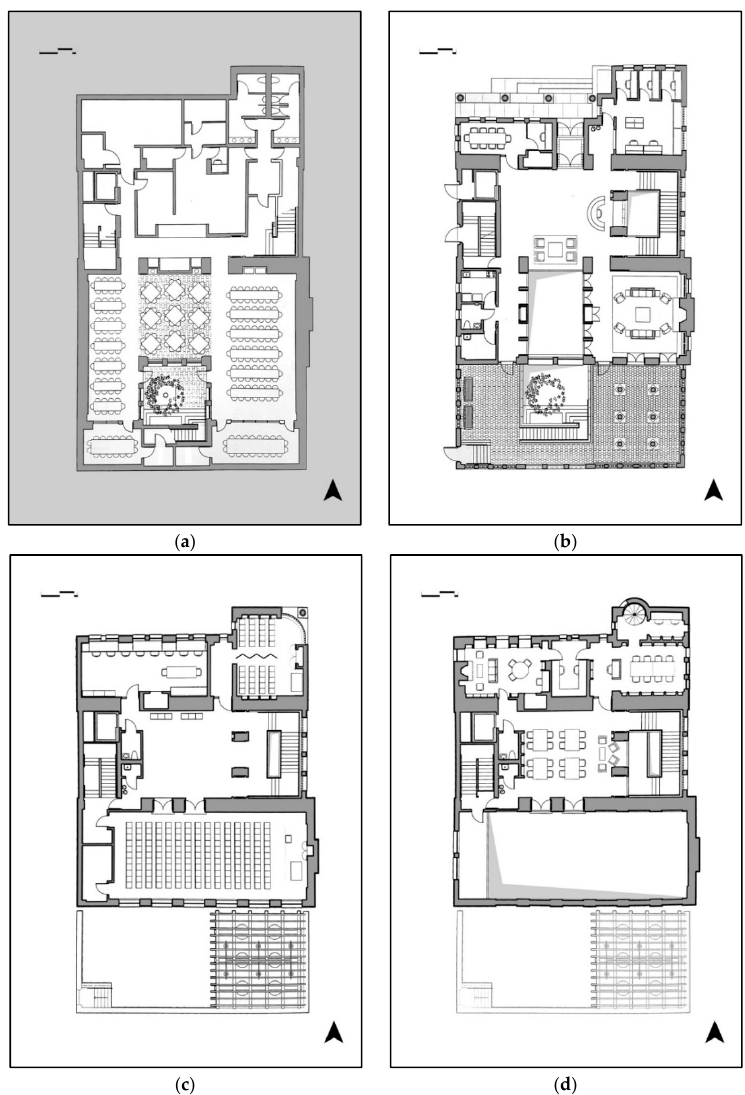
Figure 6. Slifka Center for Jewish Life at Yale, Interior Plans. ( a ) Library (upper level); ( b ) library ceiling (upper level); ( c ) library (upper level); ( d ) library ceiling (upper level). Image Credits: © Roth and Moore, Architects, used by permission.